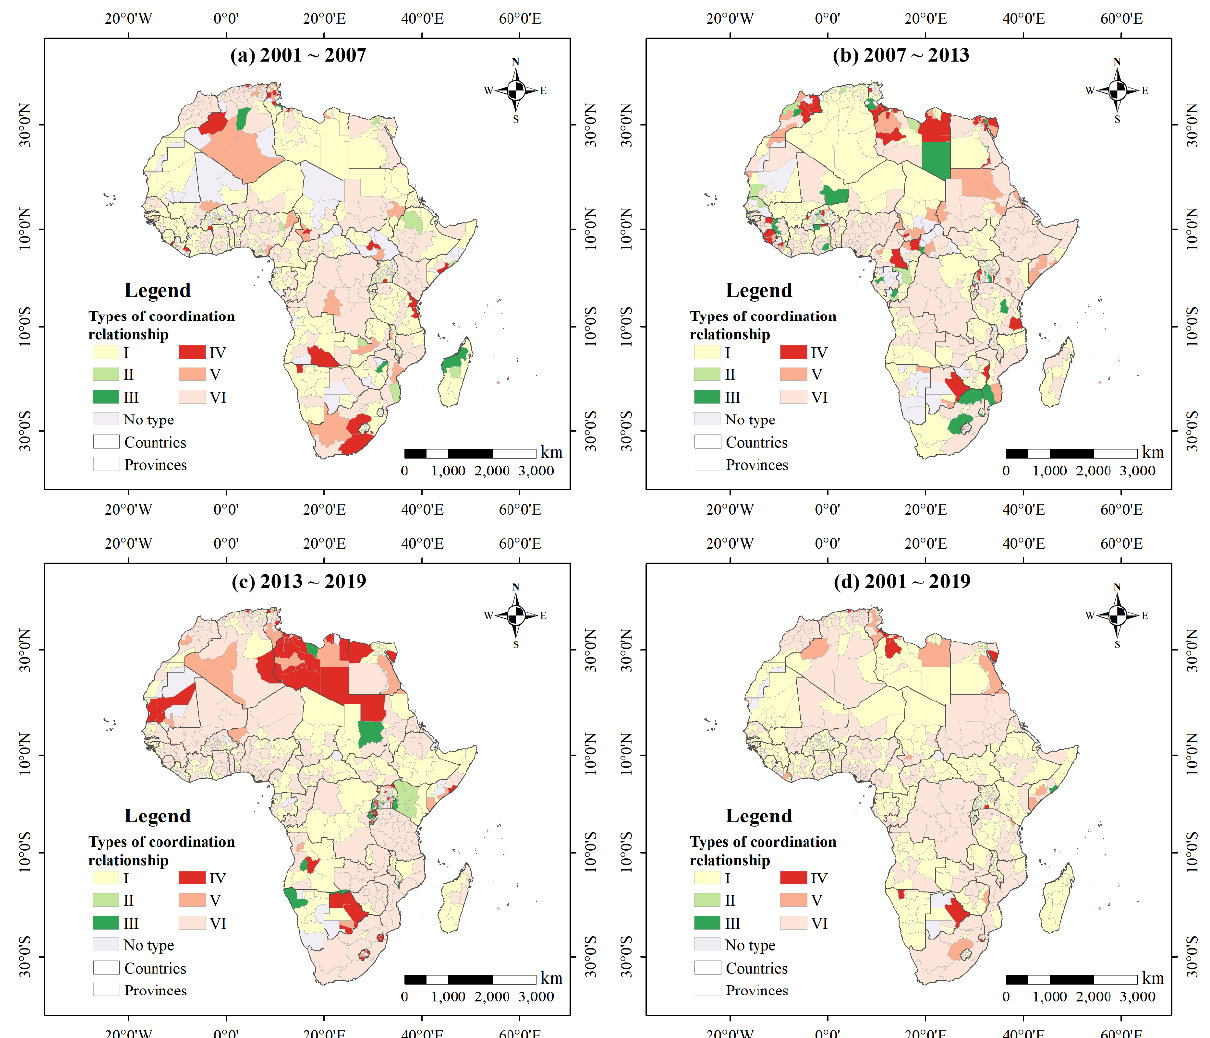
Figure 11. Spatial changes of coordination relationships in different periods.